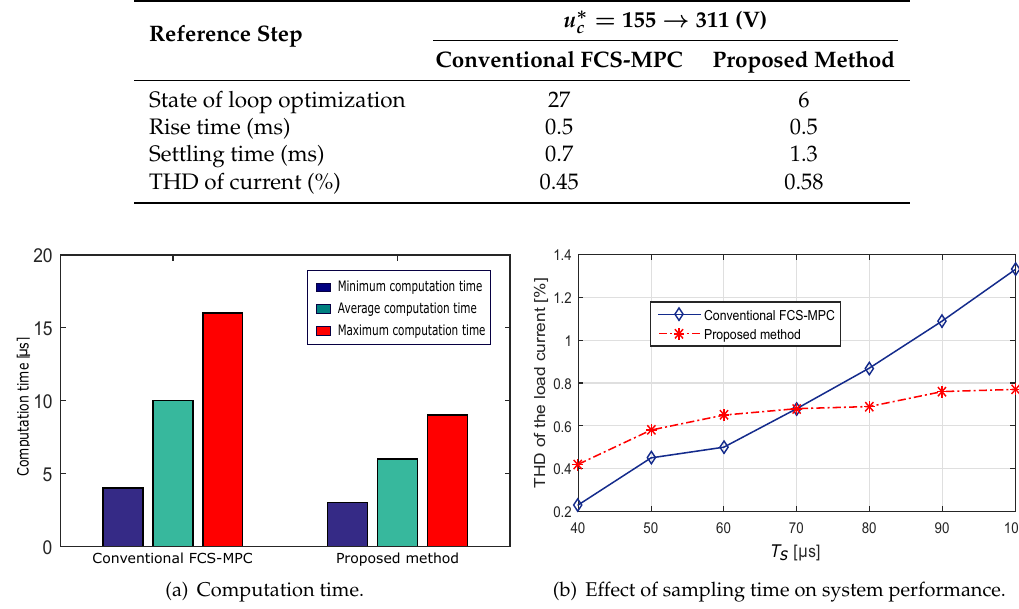
Figure 11. Comparison of two control